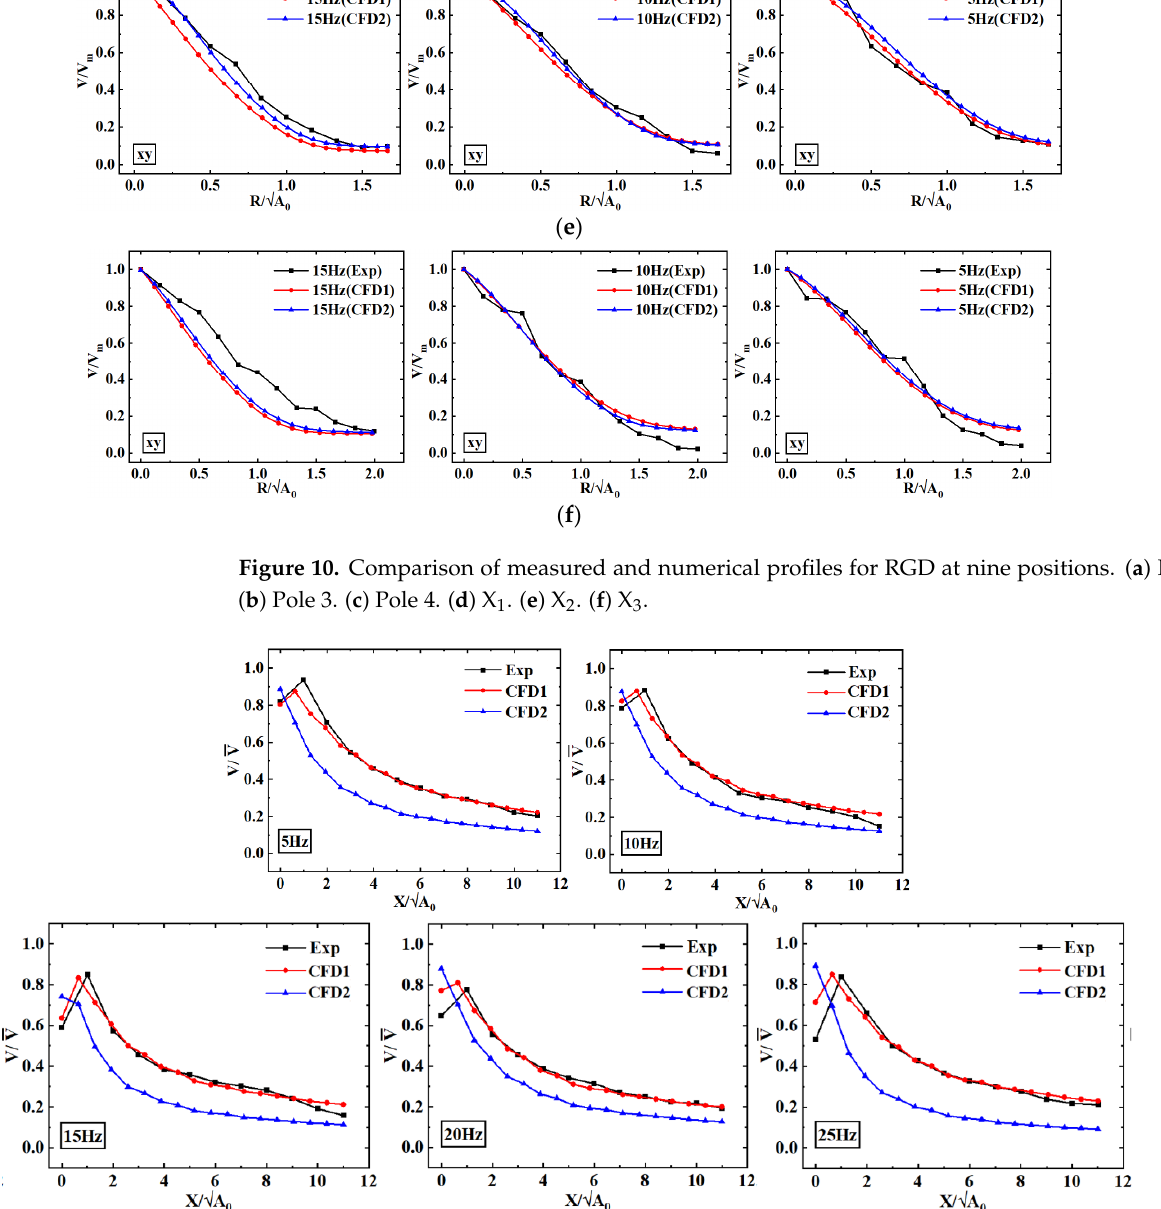
Figure 11. Comparison of measured and numerical profiles for SCD at Z 4 .